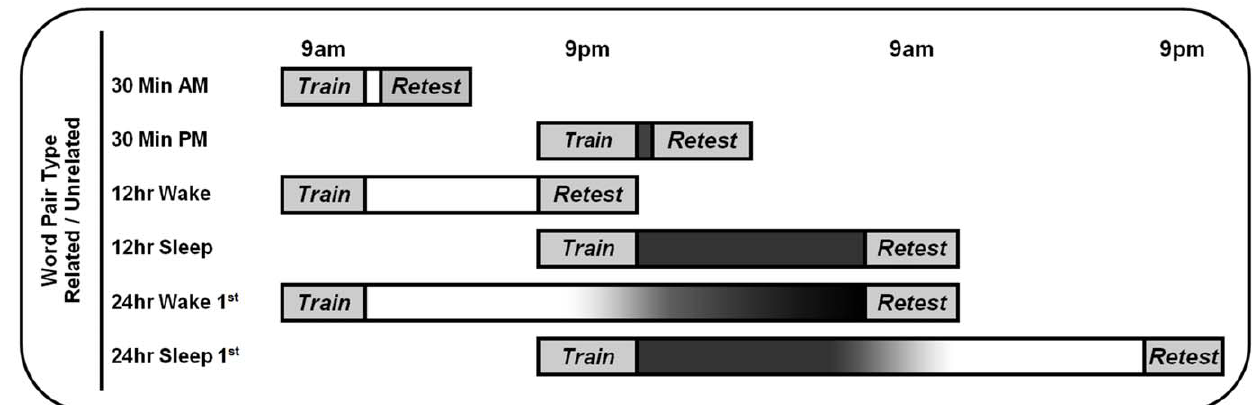
Figure 1. Study Design. White indicates wakefulness; dark gray indicates sleep.